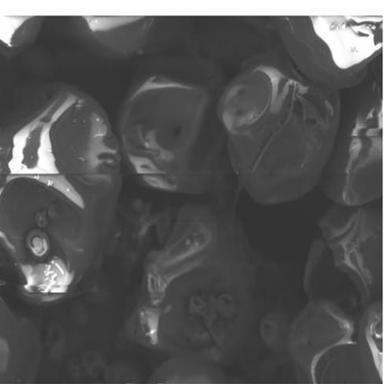
SEM images of a) PVP at ×500 scale b) PVPO at ×500 scale c) Hybrid Material at ×500 scale and d) Hybrid Material at ×10 k scale.